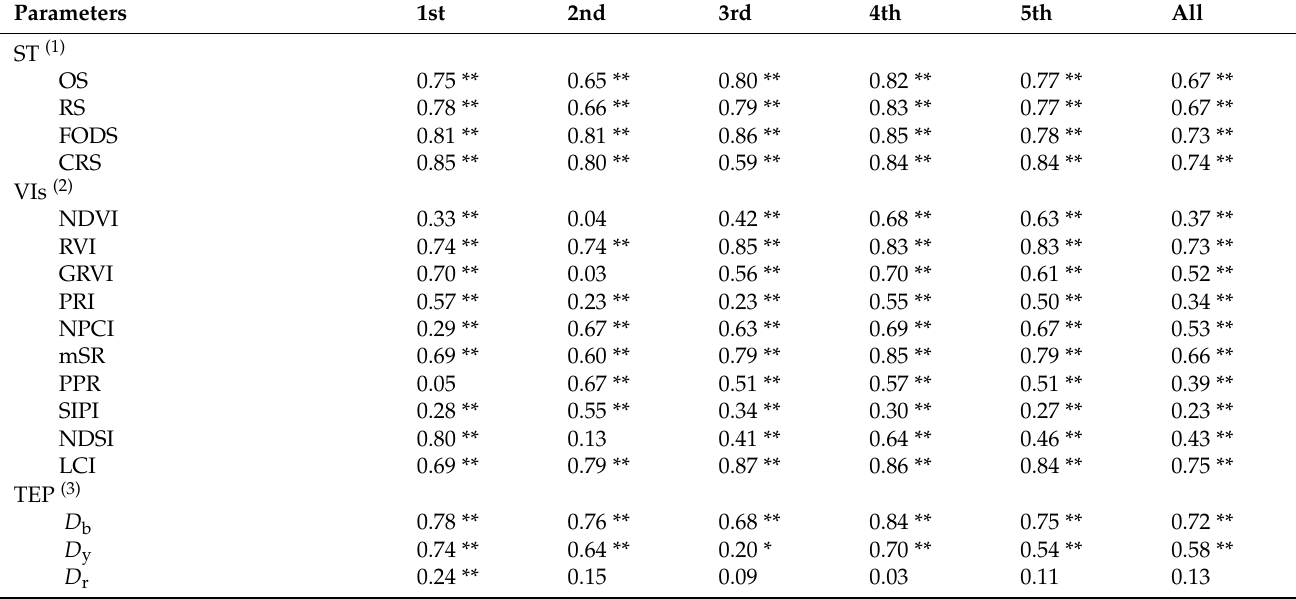
Figure 3. Correlation coefficients between LCC and spectral transformation at the different growth stages. ( a ) 1st growth stage; ( b ) 2nd growth stage; ( c ) 3rd growth stage; ( d ) 4th growth stage; ( e ) 5th growth stage; ( f ) All growth stages. OS: original spectrum; RS: reciprocal transformed spectrum; FODS: first − order differential spectrum; CRS: continuum removal spectrum. Table 4. Correlation relationship between LCC and different variables.